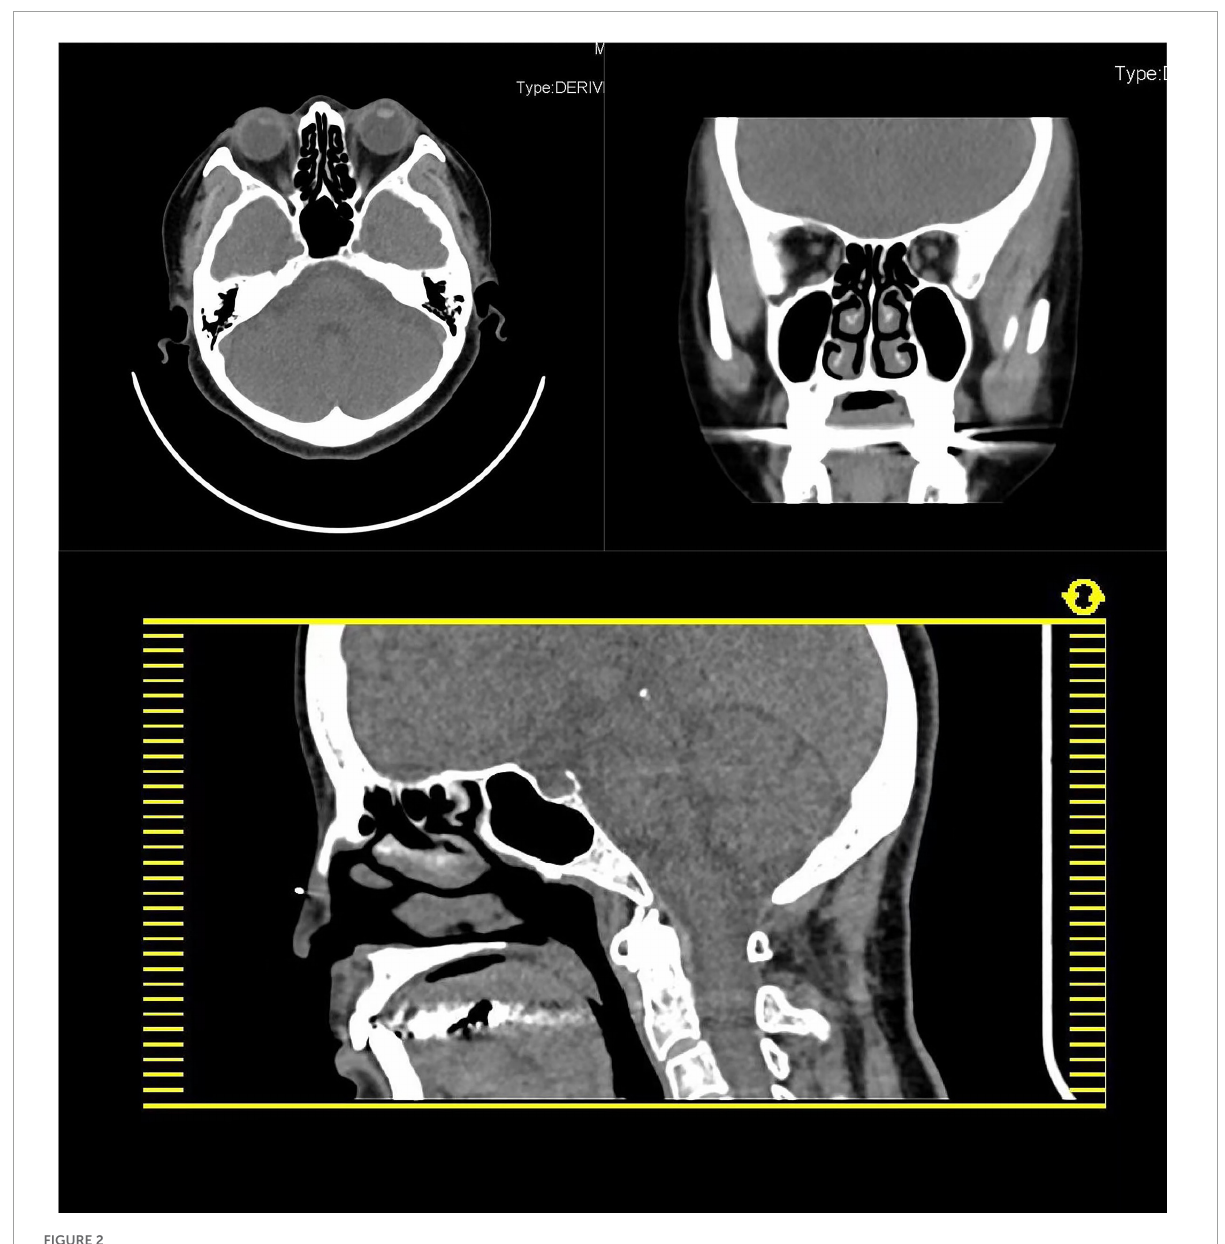
FIGURE2 Axial and coronal computed tomography of the nose showed only paranasal sinusitis.